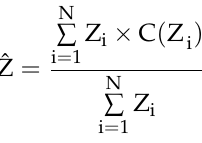
Figure 5. Results of the defuzzification process.